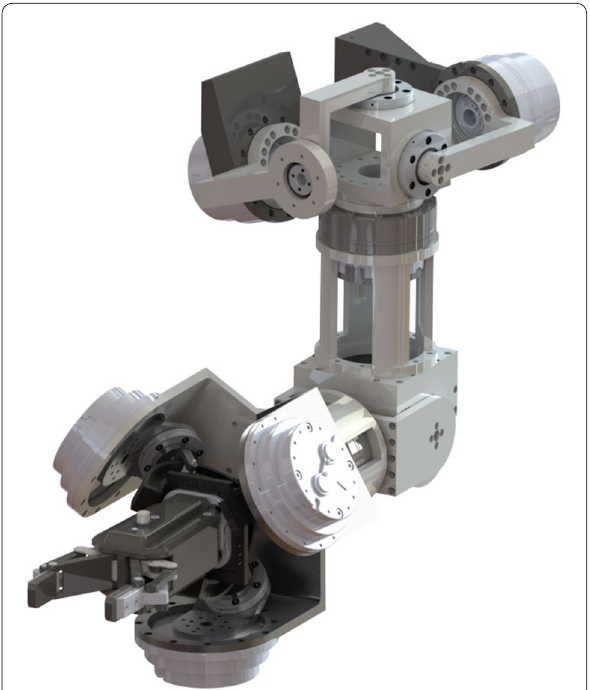
Figure 1 Three-dimensional model of the HRA (left